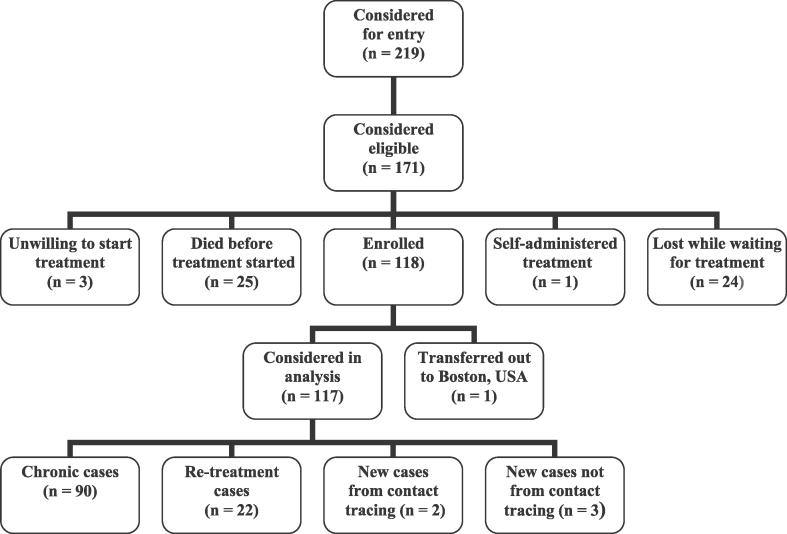
Patient Enrollment in DOTS-Plus Project, 1 April 1999 to 31 March 2002